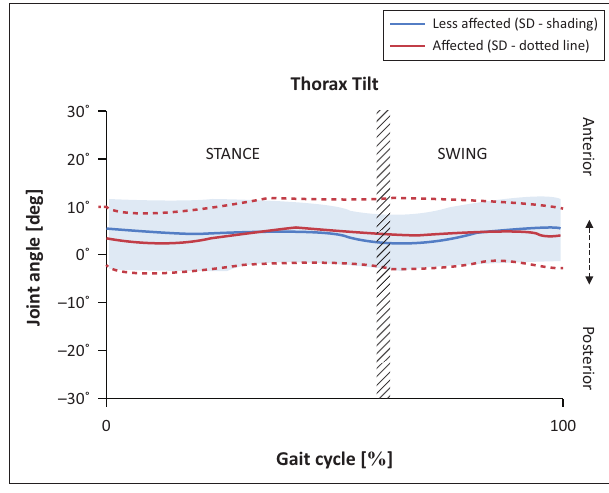
FIGURE 1: Trunk kinematics in the sagittal plane affected versus unaffected.